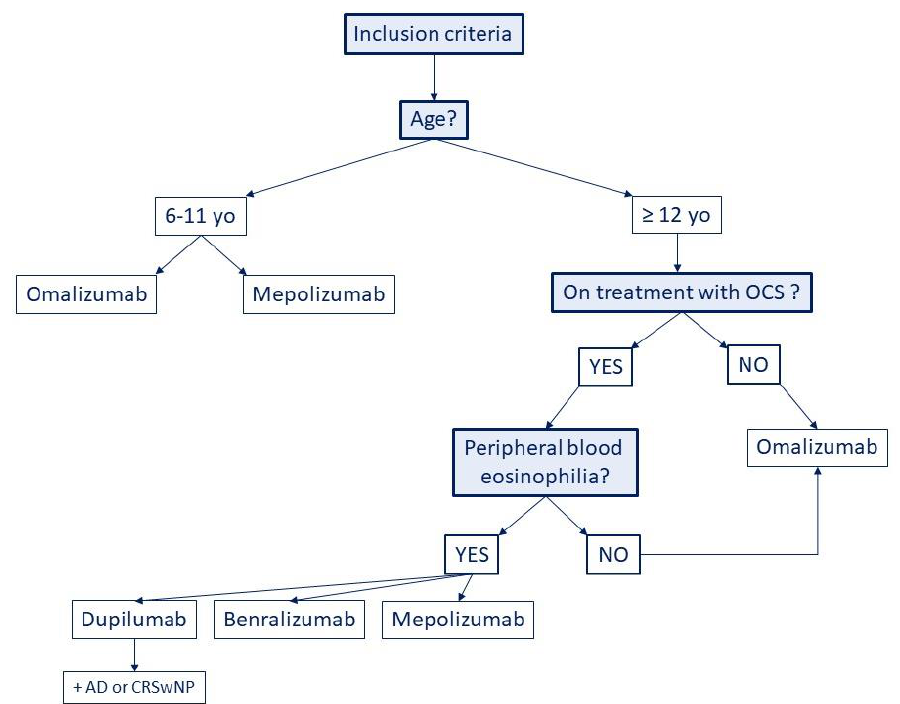
Figure 2. A flowchart to help physicians to choose the best biologic therapy in severe asthma. Yo = years old; OCS = oral corticosteroids; DA = atopic dermatitis; CRSwNP = chronic rhinosinusitis with nasal polyposis.